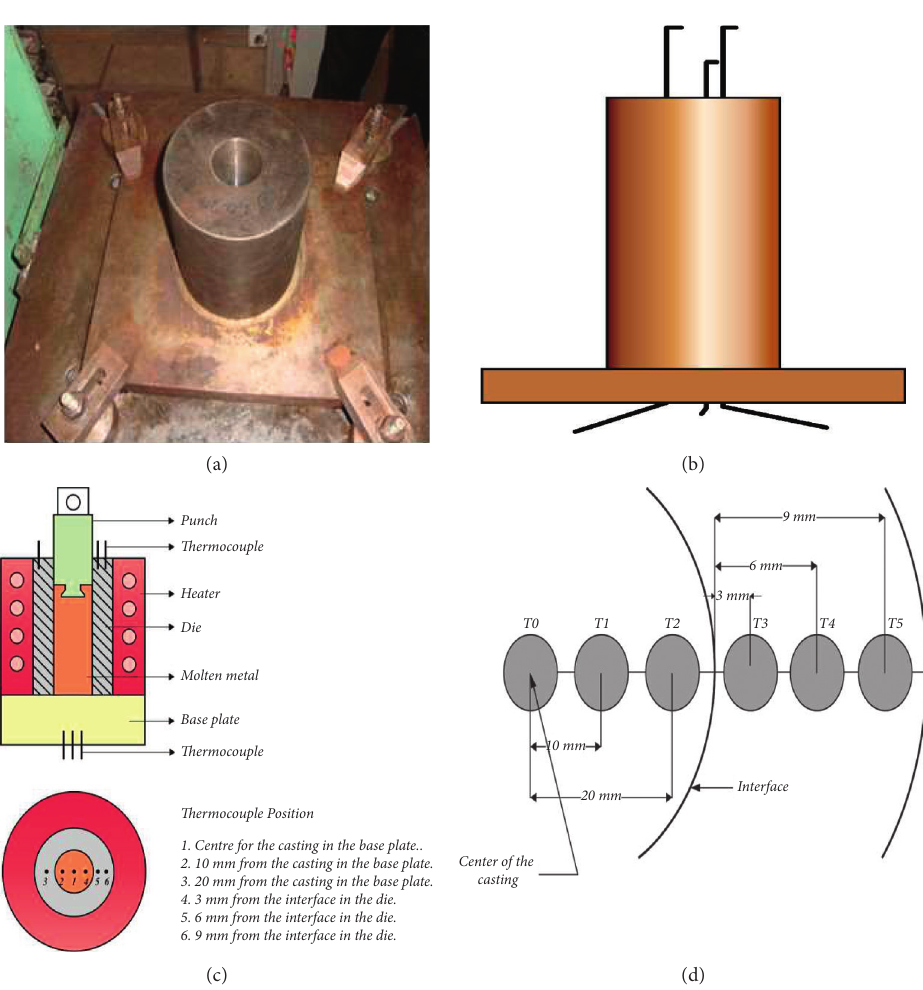
Figure 4: (a) Die and baseplate. (b) Appropriate locations of thermocouples for the complete setup. (c) Experimental squeeze cast setup. (d) Exact locations of thermocouples in the baseplate and die